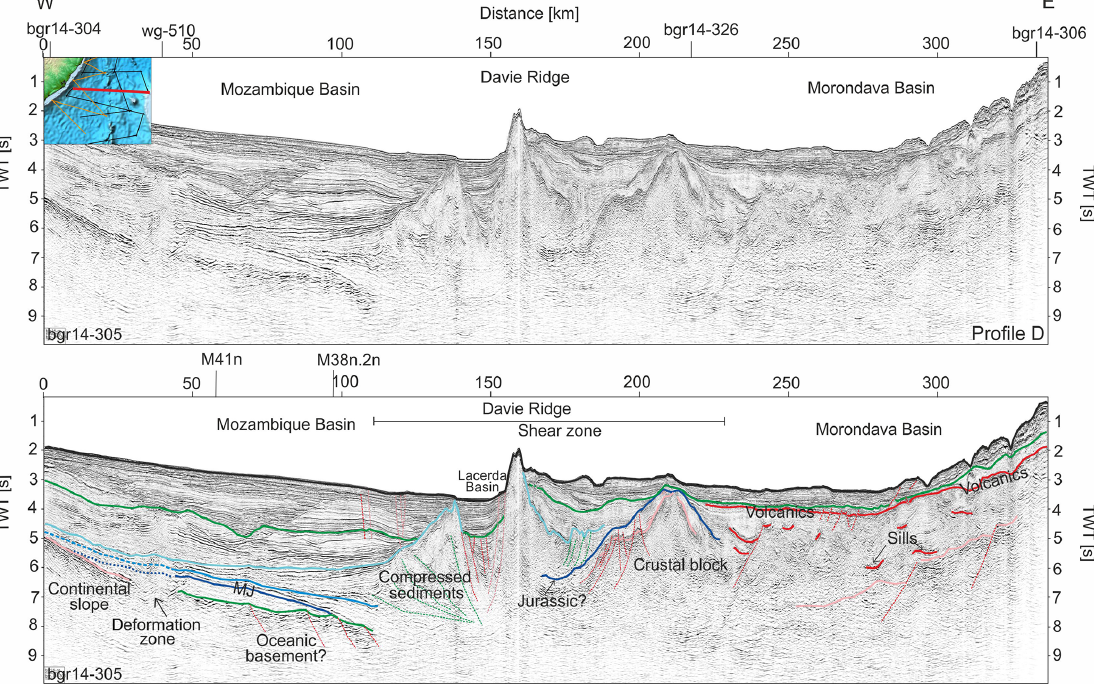
Figure 6. Pre-stack migrated section of profile BGR14-305 (line location in inset map and in Fig. 1). The lower panel shows the interpreted section according to the seismostratigraphic concepts of Castelino et al. (2015), Franke et al. (2015), Klimke et al. (2016) and Mahan- jane (2014). The profile runs from the continental slope offshore of northern Mozambique across the Davie Ridge into the Morondava Basin offshore of Madagascar. The zone of deformed basement is observed at the foot of the continental slope (offset range: 30–50km) where the basement is not imaged, which is probably due to the intense faulting of the basement. The Davie Ridge shows a clear morphological expression in the center of the profile. The shear zone, however, is much wider and, including the Davie Ridge, it is characterized by three prominent crustal blocks. Overall, the deformation zone extends over ∼ 120km perpendicular to the shear movement. The westernmost block consists of deeply buried, compressed sediments that might have been thrusted onto the oceanic crust during southward motion of